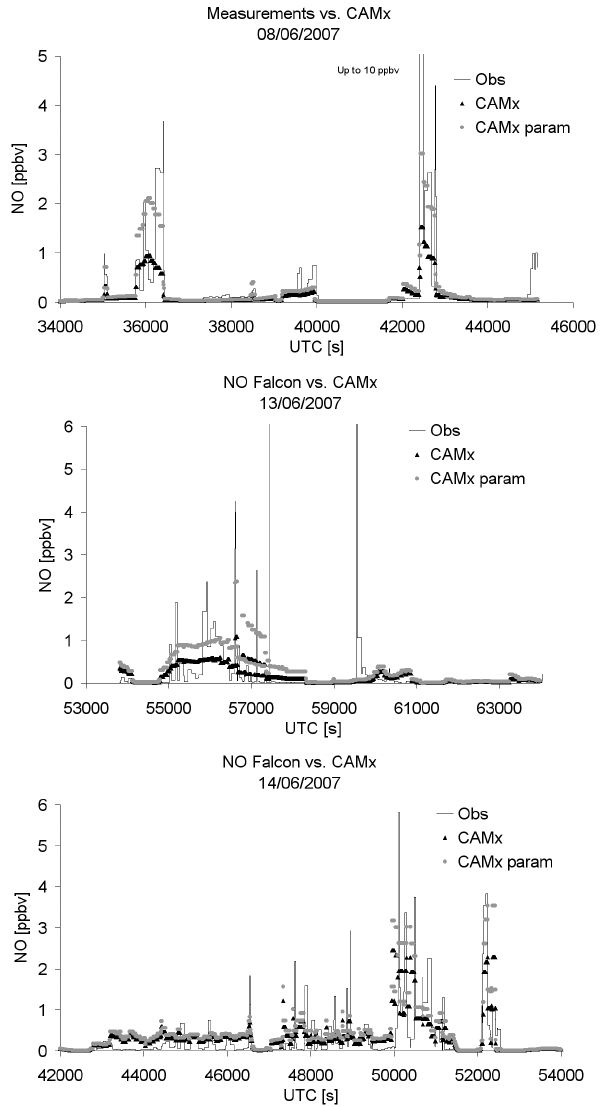
Fig. 14. Comparison of simulated nitrogen monoxide levels with aircraft ship emission measurements over the English Channel in June 2007. Black triangles denote the run without the ship plume parameterization, the gray circles the run with the